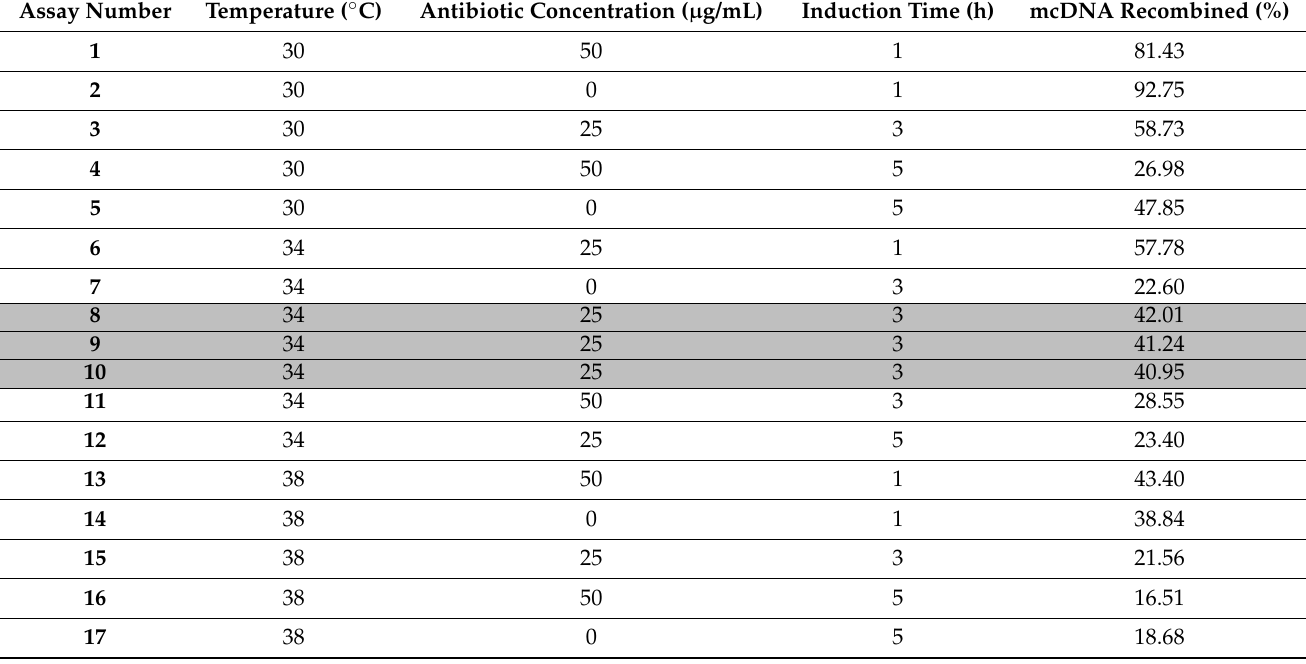
Table 1. Percentage of mcDNA recombined obtained for each condition of DoE